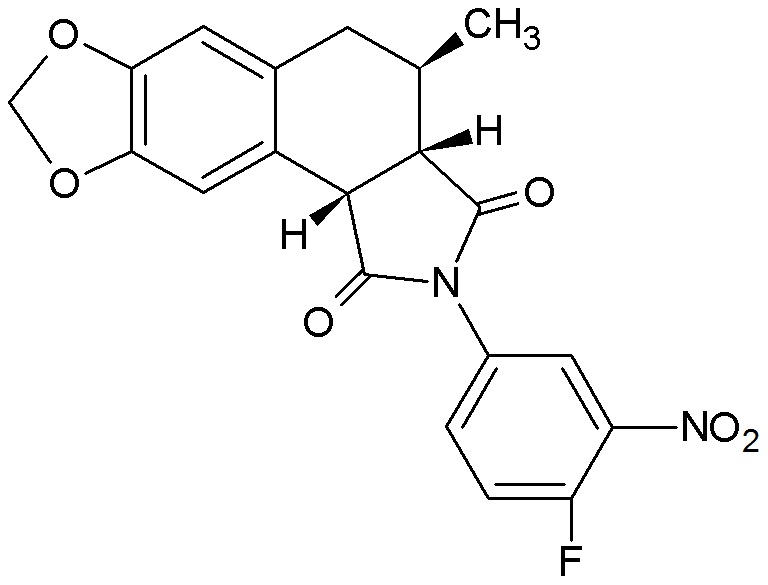
Chemical structure of A398.